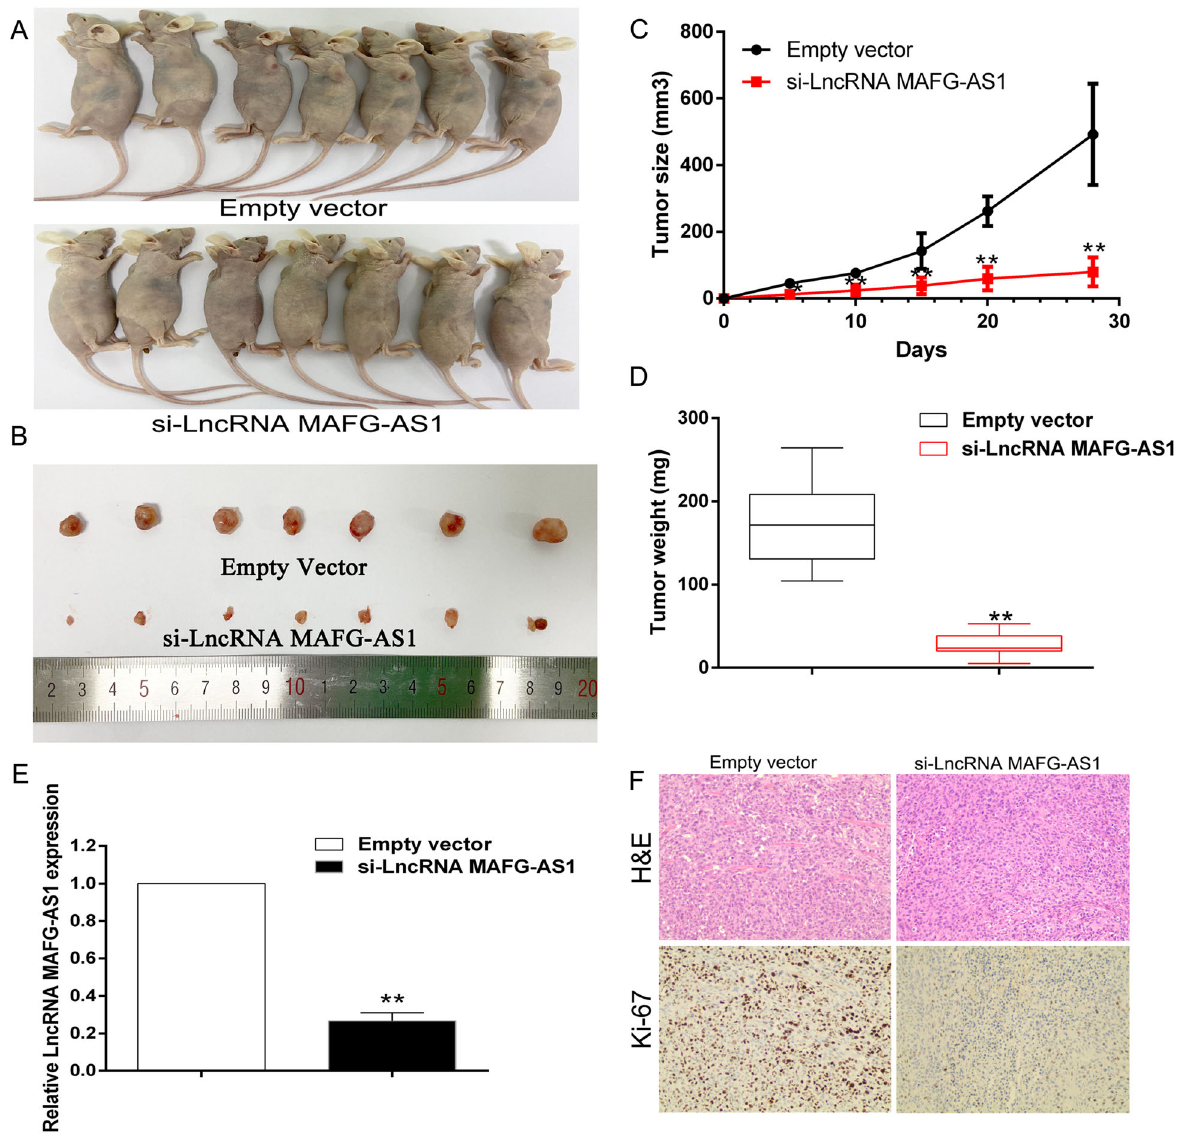
Fig. 5 LncRNA MAFG-AS1 knockdown inhibits tumorigenesis of BC cells in vivo. A , B Empty vector or si-LncRNA MAFG-AS1 was transfected into T-47D cells, which were injected in the BALB/c-nude mice ( n = 7), respectively. Tumors before and after carrying from the nude mice. C Tumor volumes were calculated after injection every 5 days. Points, mean ( n = 7); bars indicated SD. D Tumor weights were represented as means of tumor weights ± SD. E qRT-PCR was used to detect the average expression of LncRNA MAFG-AS1 in xenograft tumors ( n = 7). F The tumor sections were under H&E staining and IHC staining using antibodies against Ki-67. * P < 0.05, ** P <